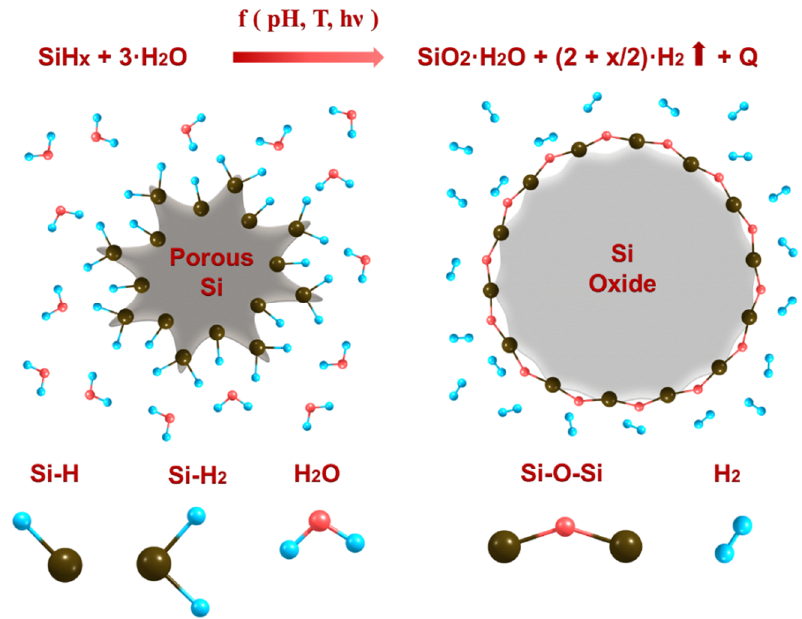
Figure 1. Transformation of partially hydrogenated PSi nanoparticles in silicon oxide in water solution.